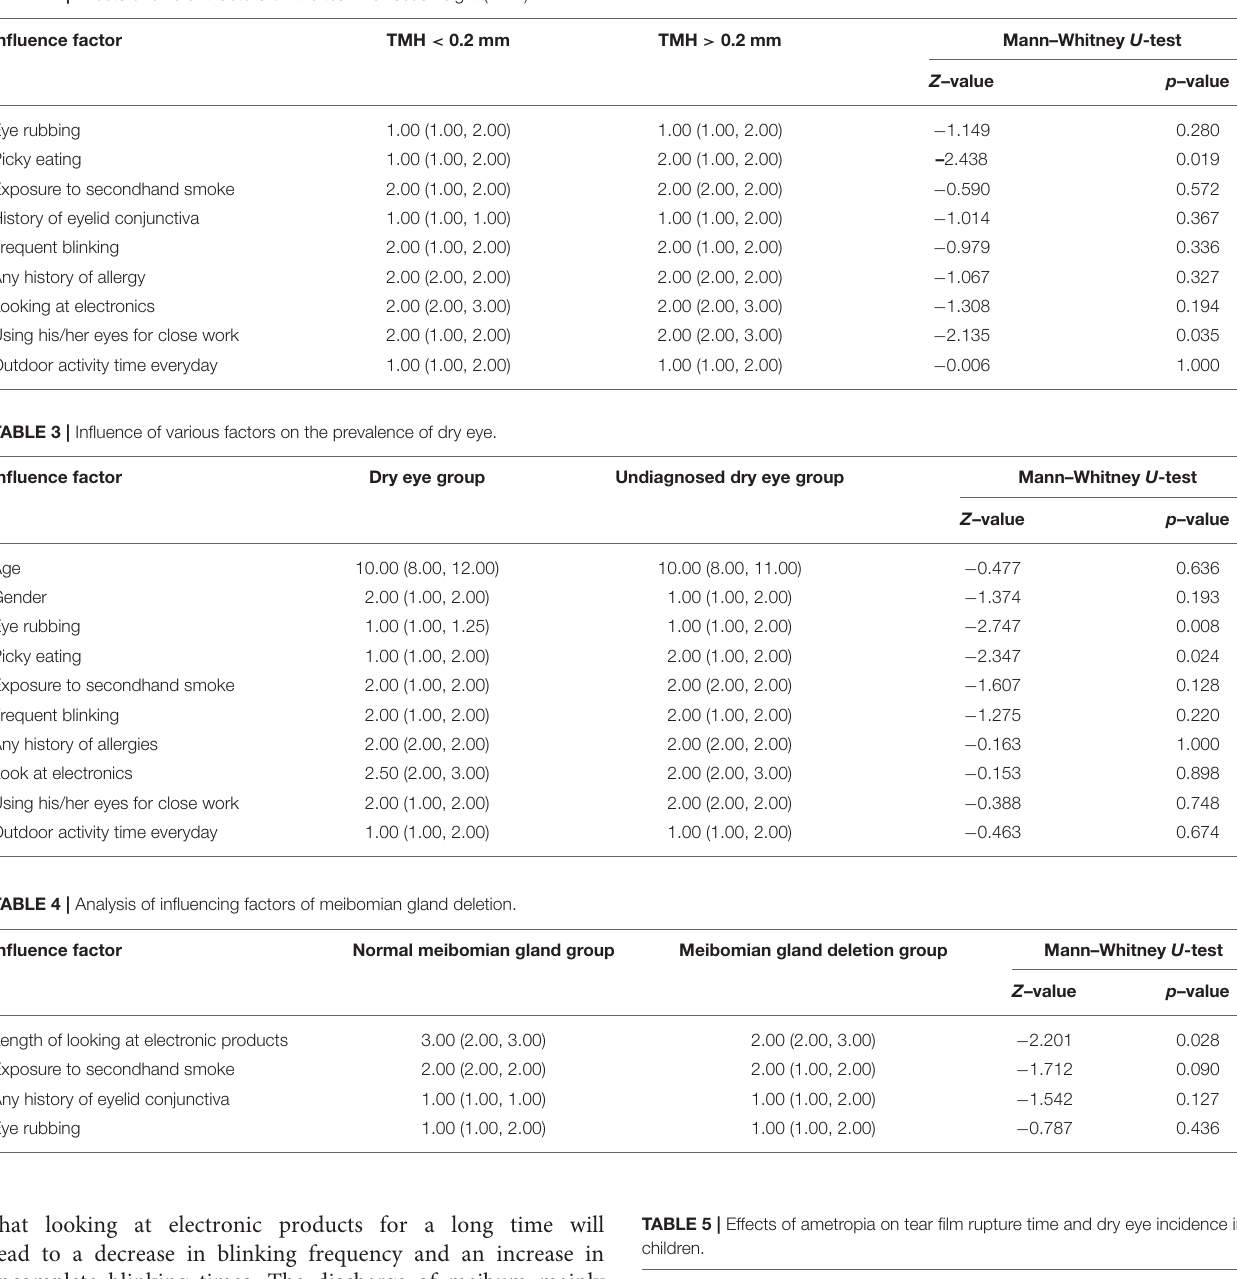
TABLE 2 | Effects of different factors on the tear meniscus height (TMH).